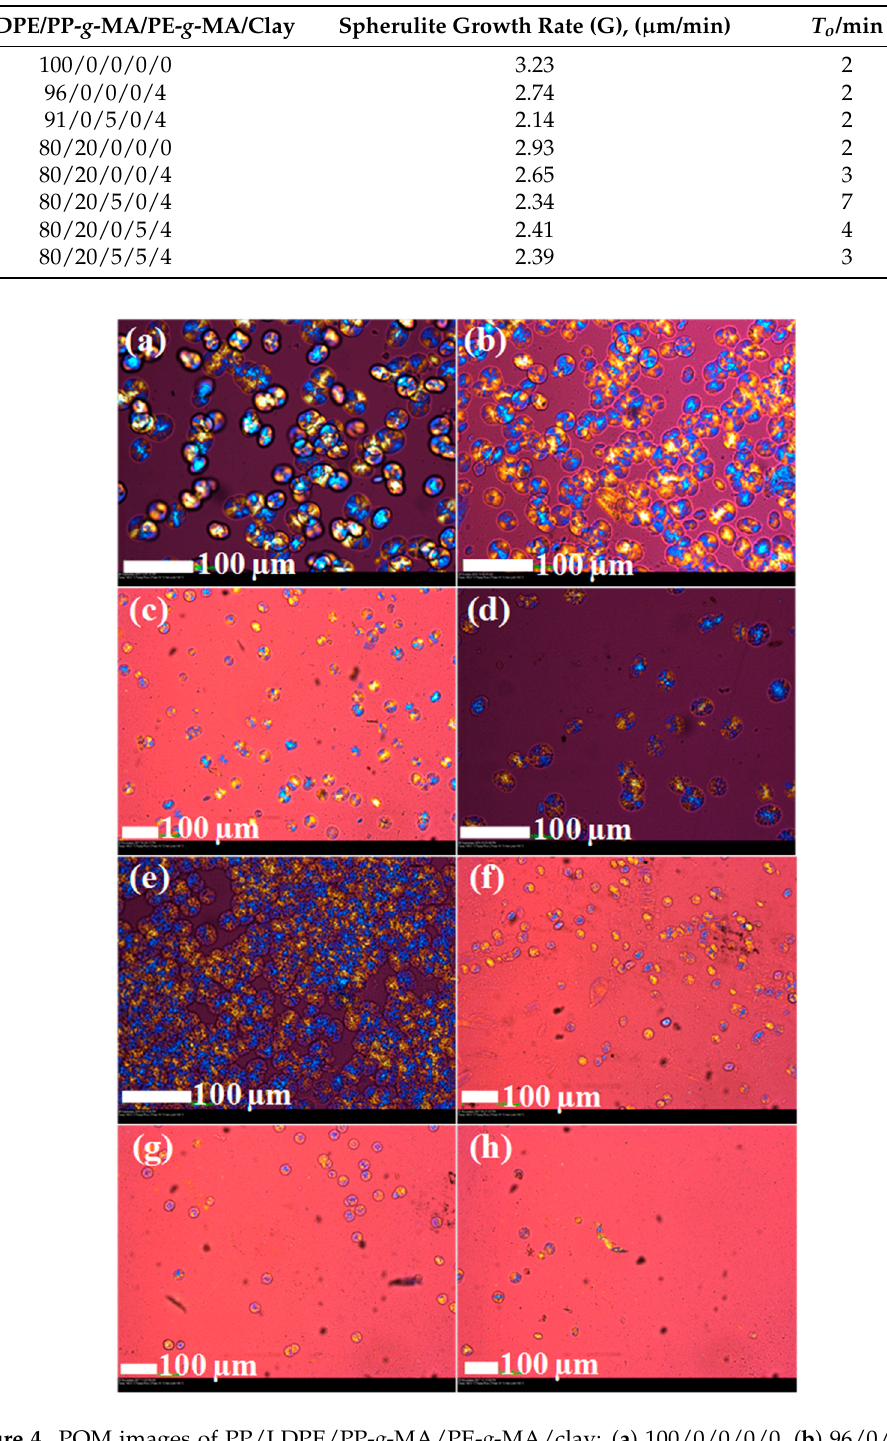
Figure 4. POM images of PP/LDPE/PP- g -MA/PE- g -MA/clay: ( a ) 100/0/0/0/0, ( b ) 96/0/0/0/4, ( c ) 91/0/5/0/4, ( d ) 80/20/0/0/0, ( e ) 80/20/0/0/4, ( f ) 80/20/5/0/4, ( g ) 80/20/0/5/4, and ( h ) 80/20/5/5/4. The samples were melted at 200 °C followed by isothermal crystallisation at 140 °C for 30 min. The images were taken after 10 min during isothermal crystallisation.